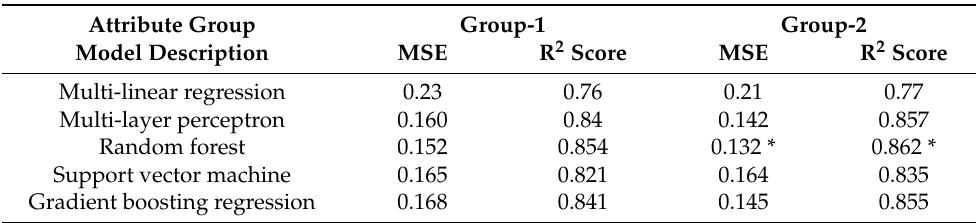
Table 8. Supervised ensemble learning model’s performance of two different attribute groups in Goldwyer formation for TOC prediction. Every model’s accuracy is represented by MSE and R 2 on the validation data set.